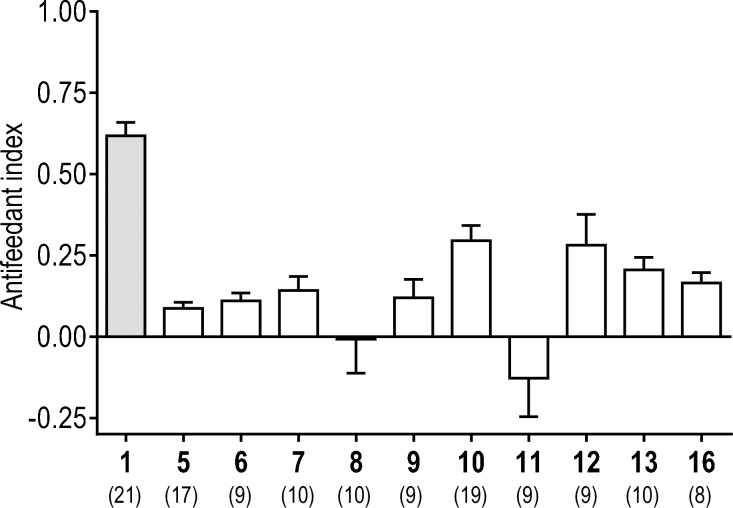
Antifeedant activity of CDIAL and semi-synthetic derivatives as determined via choice CAFE assays in adult female Ae. aegypti (LVP strain).Mosquitoes were allowed to feed equally on two capillaries of 10% sucrose with 0.01% trypan blue; the control capillary included 1% DMSO, and the treatment capillary included 1% DMSO and 1mM test compound. The difference in volume consumed between the capillaries was used to calculate the antifeedant activity [21]. Values are means ± SEM based on at least 8 replicates of 5 adult females each. The specific numbers of replicates for each are indicated in parentheses below the compound number. Shading indicates statistical categorization of derivative’s efficacy relative to CDIAL as in Fig 7.